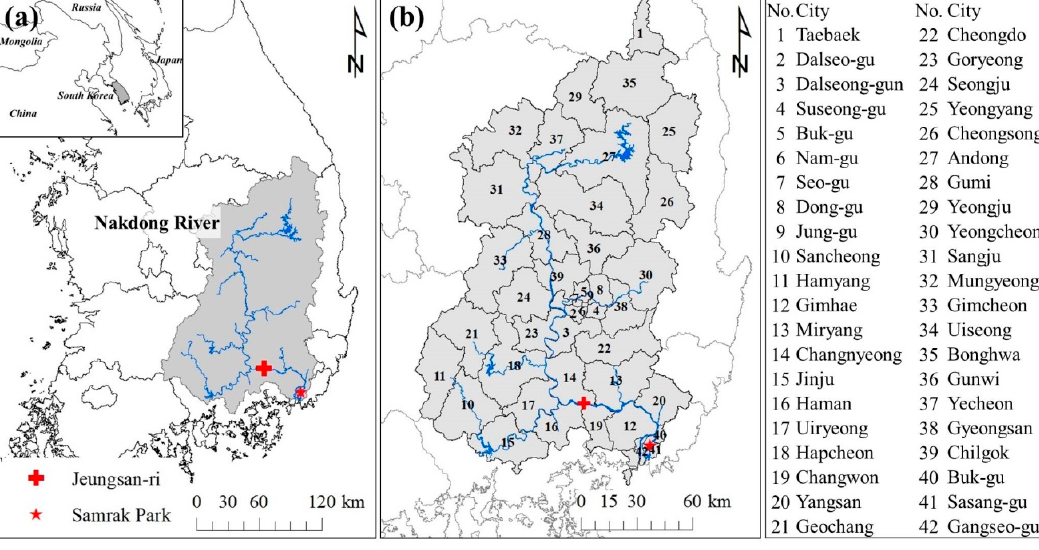
Figure 1. ( a ) Location of Managed Aquifer Recharge (MAR) sites (Jeungsan-ri and Samrak Park); ( b ) the cities in the Nakdong River Basin.